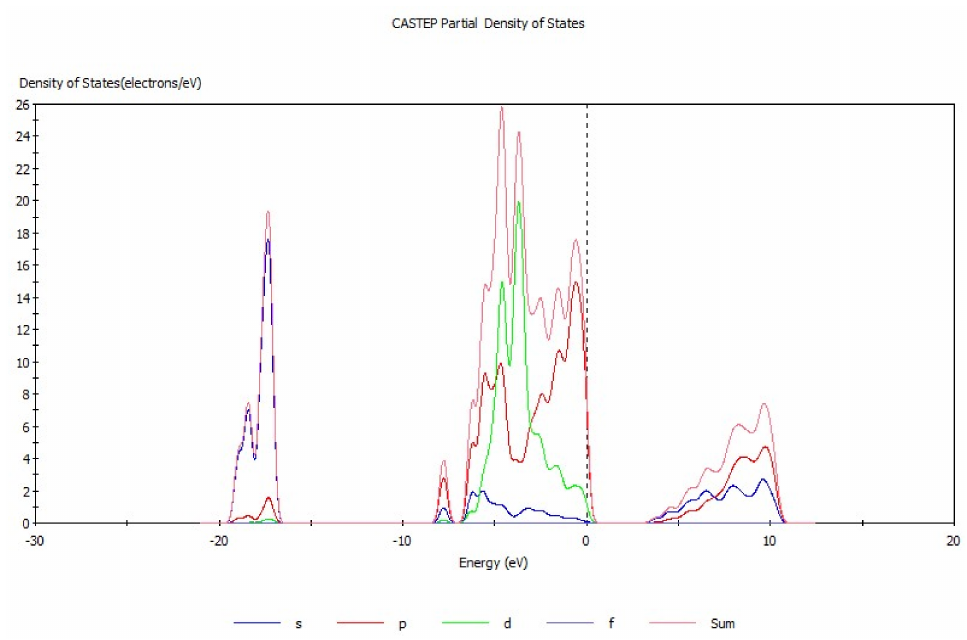
Figure 4. Partial densities of states of